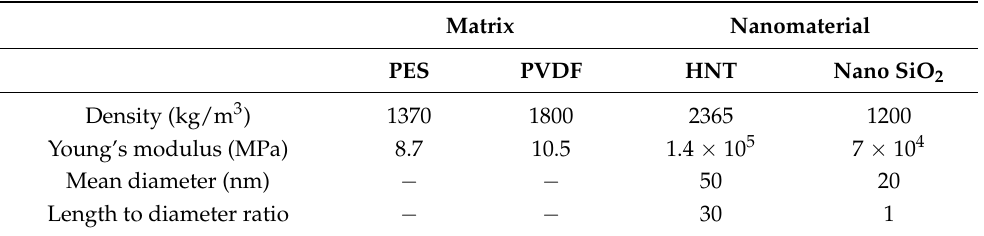
Table 1. Mechanical properties of materials used in homogenisation method. Matrix Nanomaterial PES PVDF HNT Nano SiO